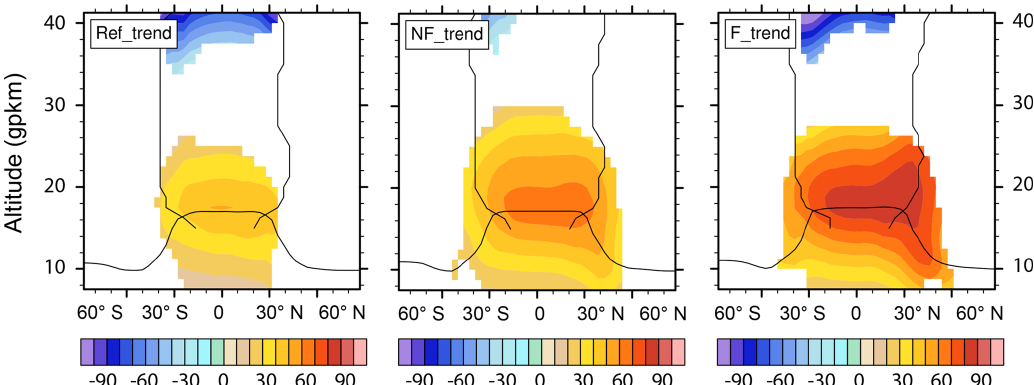
Figure 3. CMAM trend of geopotential height of pressure levels (gpm per decade) interpolated to the climatological geopotential height of the selected pressure levels in each period. The mean tropopause and turnaround latitude positions are marked with black lines. Only the trends in the regions where they exceed the statistical significance of 95% confidence level are plotted.